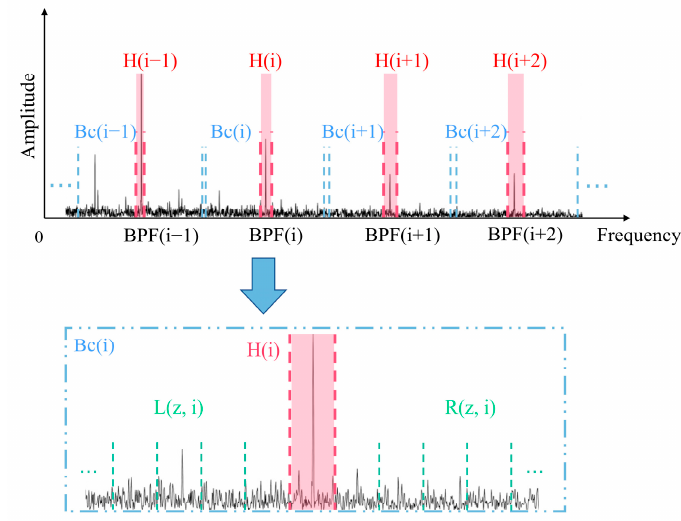
Figure 2. Schematic of BC